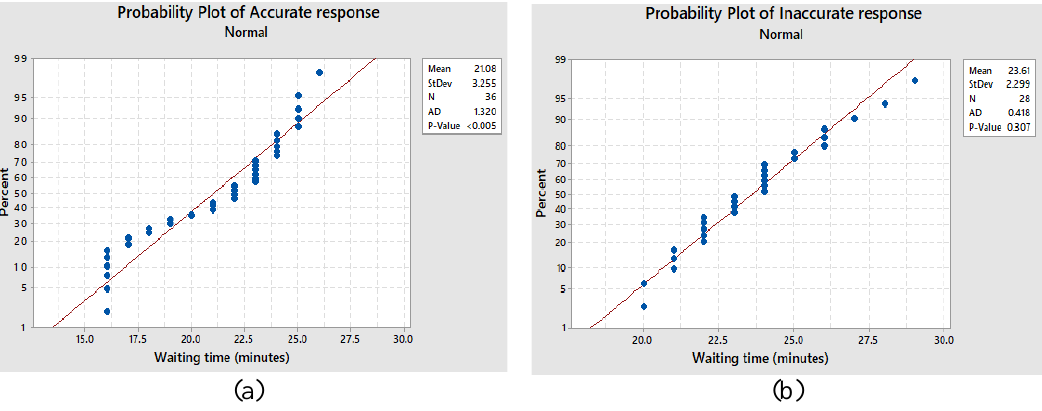
Figure 9. Probability plot for the onboarding process with accurate response (a) and inaccurate response